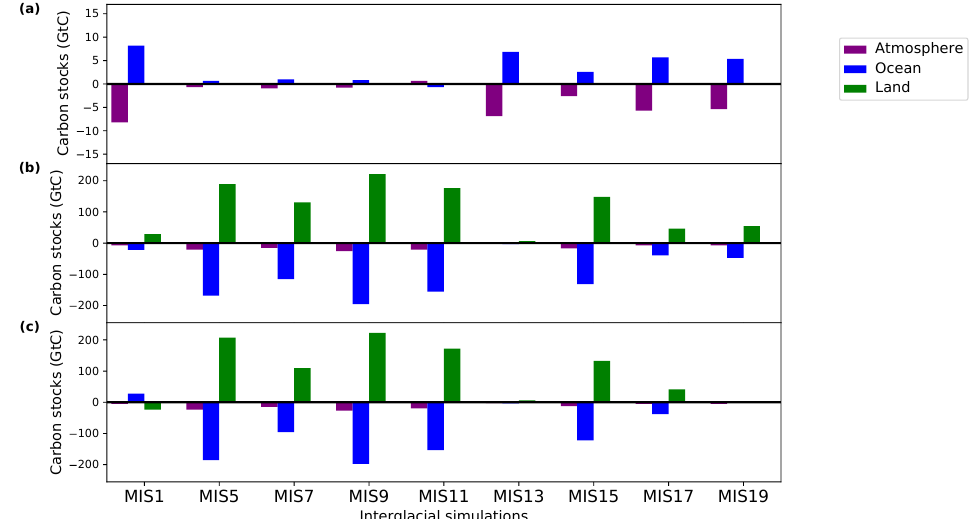
Figure 10. Carbon stocks (GtC) in the three reservoirs (atmosphere, ocean and land) for each simulation. (a) OC series with fixed vegetation and fixed ice sheets, (b) OVC series with interactive vegetation and fixed ice sheets, and (c) OVIC series with interactive vegetation and different prescribed ice sheets. The stocks are given as anomalies with respect to the control pre-industrial simulation.